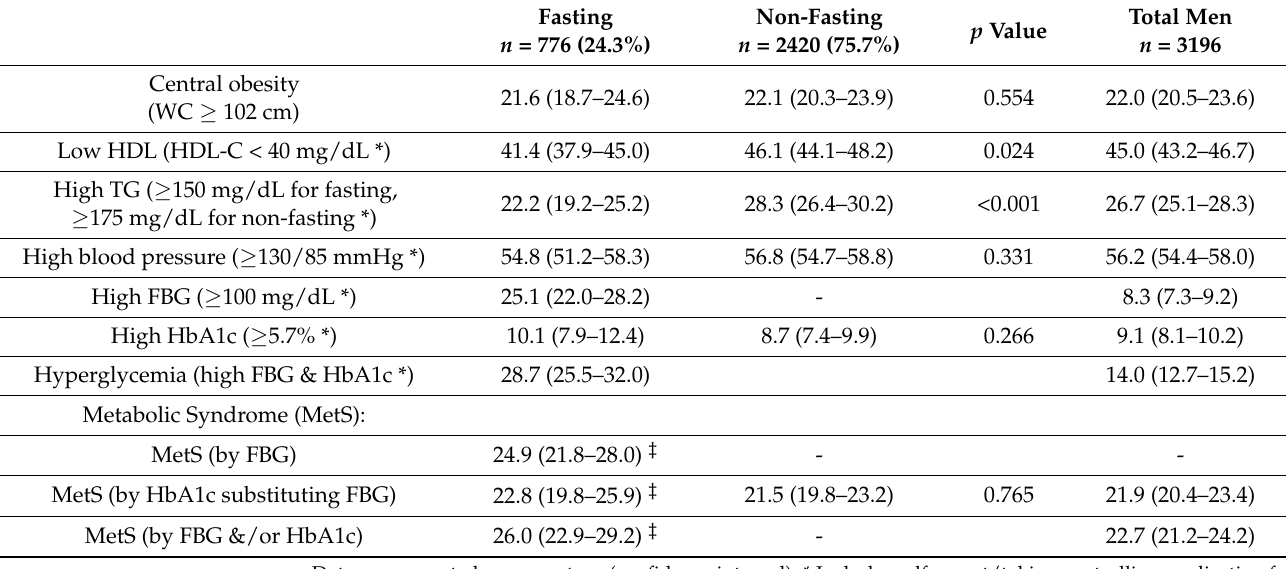
Table 2. Age-adjusted prevalence of Metabolic syndrome and its biomarkers in Men. Fasting Non-Fasting n = 776 (24.3%)